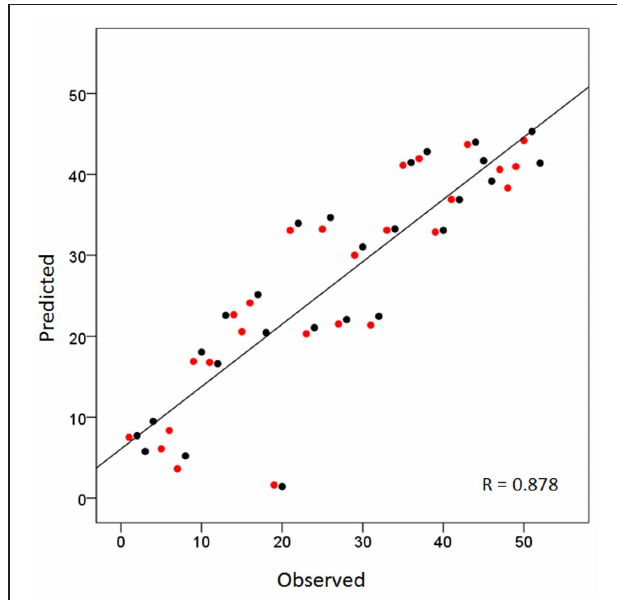
FIGURE 2 | Scatter plot of the sequence of cortical areas in the dendrogram of Figure 1 (from top to bottom) against the predicted sequence using the average Talairach coordinates (per area) as the independent variables (see text for details). Red and black denote left and right hemispheres, respectively. Homotopic areas cluster closely as doublets of red and black circles.